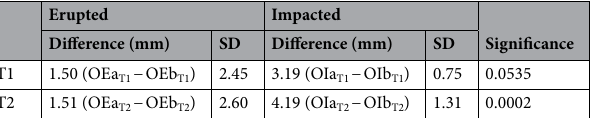
Table 4. Difference between non-cleft side and cleft side origin–canine distances at T1 and T2.